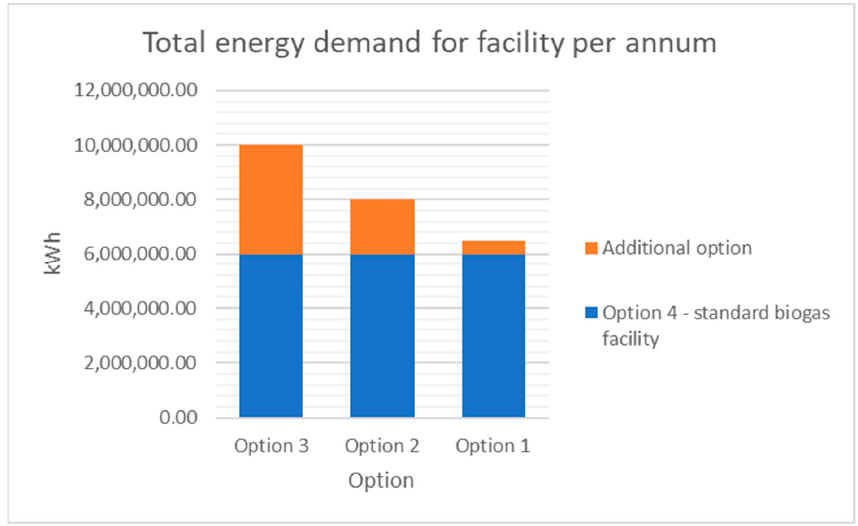
Figure 5. Total energy demand for each facility per annum.